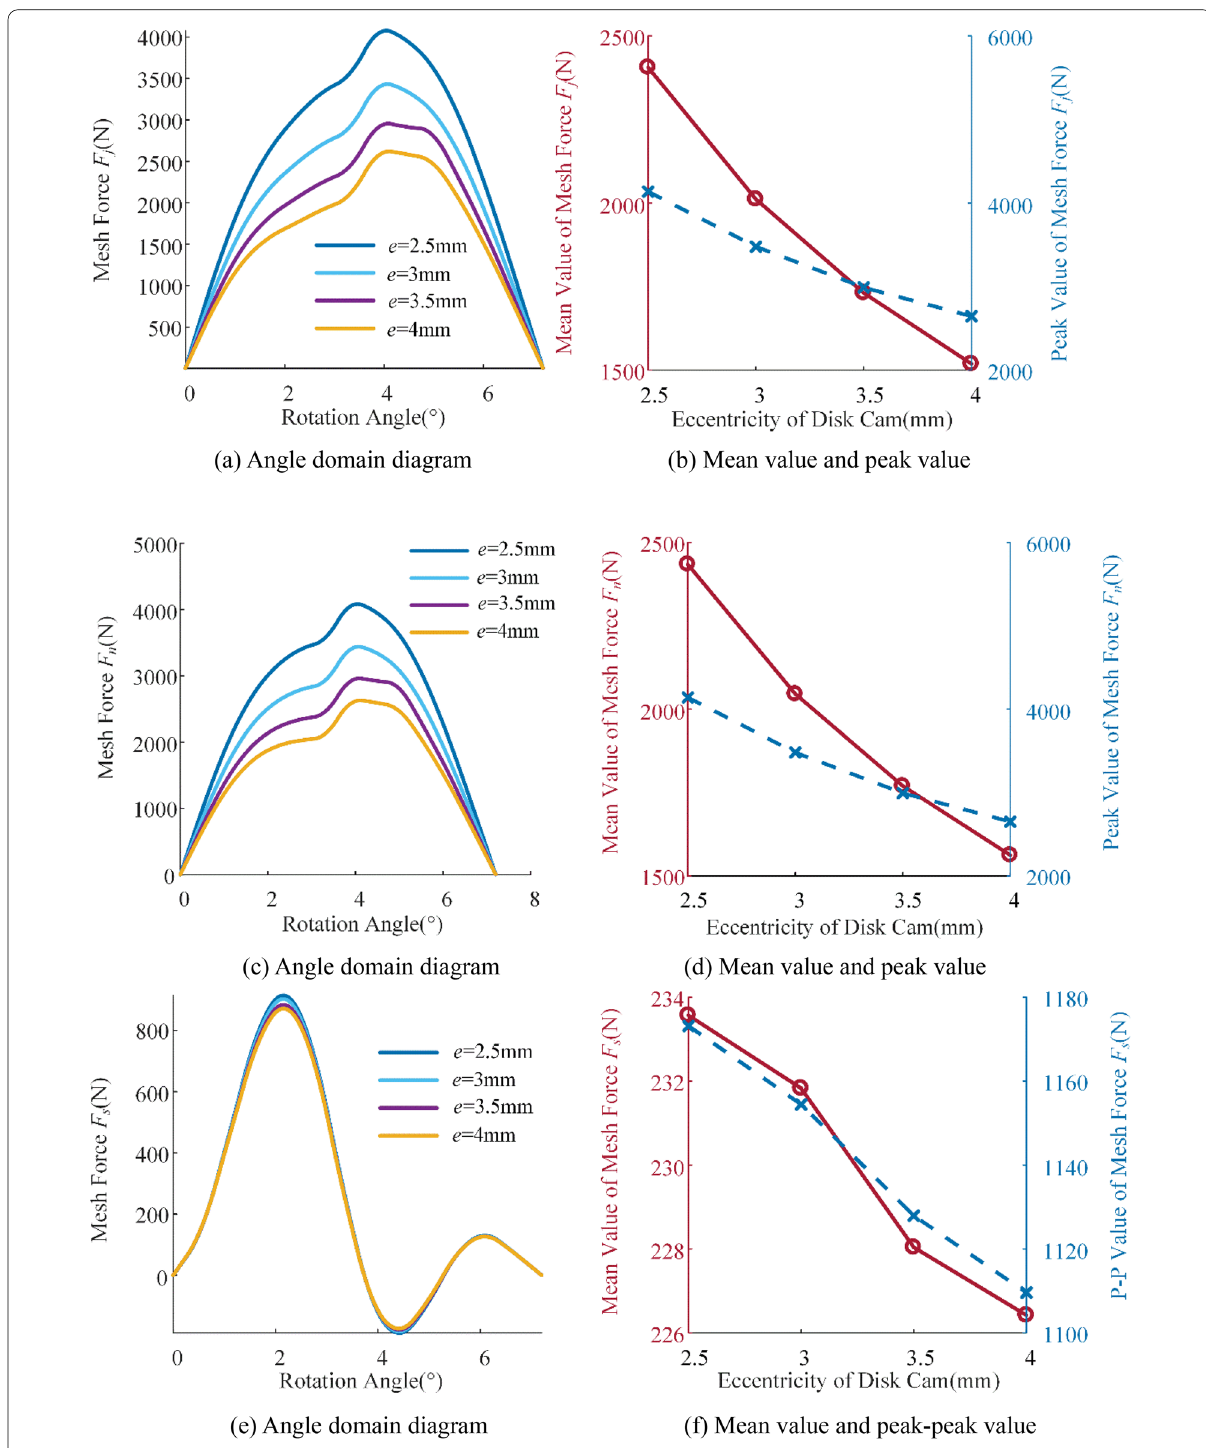
Figure 11 Impacts of eccentricity of disk cam on mesh